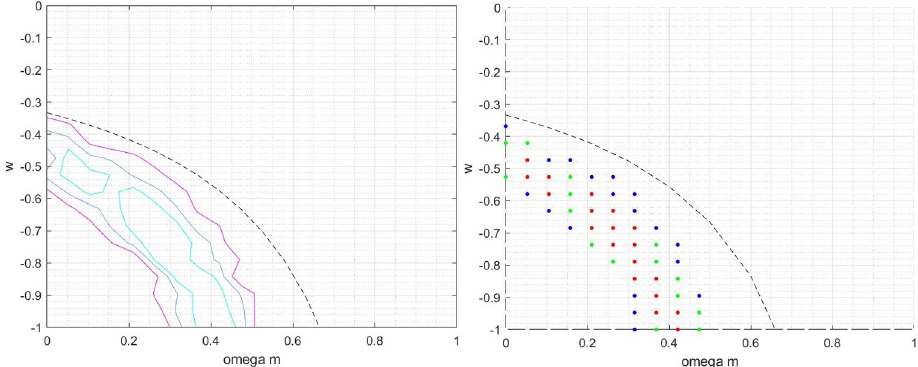
Figure 3: Contour plot (left) and scatter plot (right) of Ω m against w for Ω k = 0 with 1 σ , 2 σ and 3 σ lines. The dotted line is the line of no acceleration. We see that in our plot, the contour lines do not touch the line of no acceleration. The minimum χ 2 value is − 229 . 6220, for Ω m = 0 . 4211 and w = −